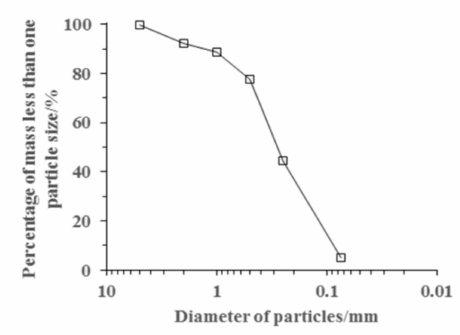
Figure 2. Particle size distribution curve for fine-grained soil.